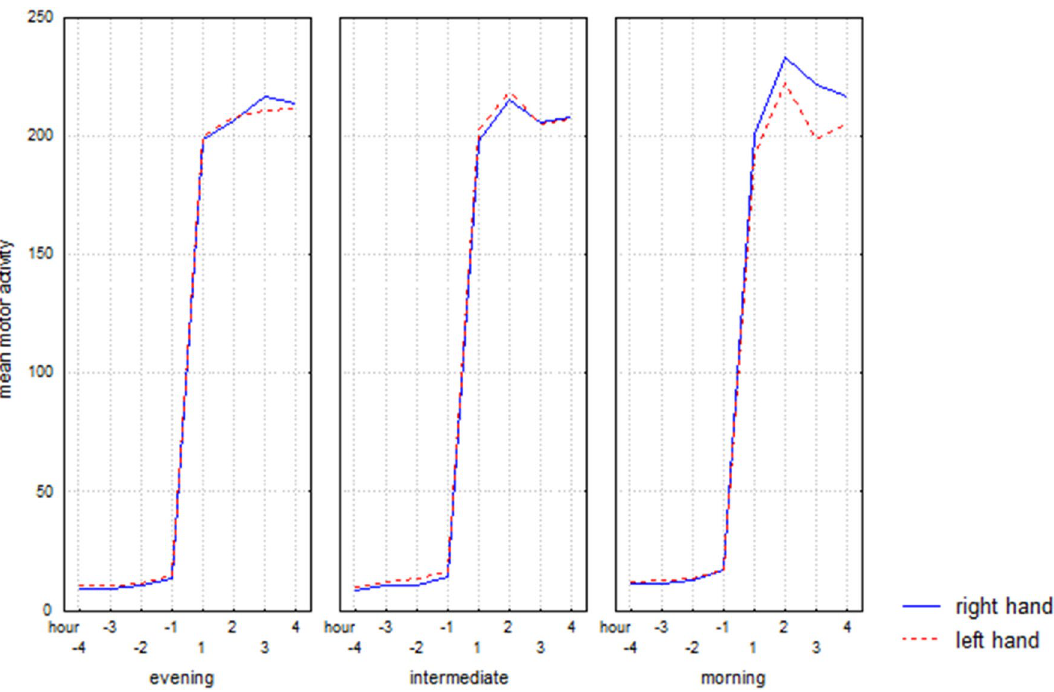
Figure 3. Hourly mean motor activity, over the time interval defined by the four hours before (− 4, − 3, − 2, − 1) and four hours after (+ 1, + 2, + 3, + 4) the get-up time, of the right and left hand in evening, intermediate, and morning